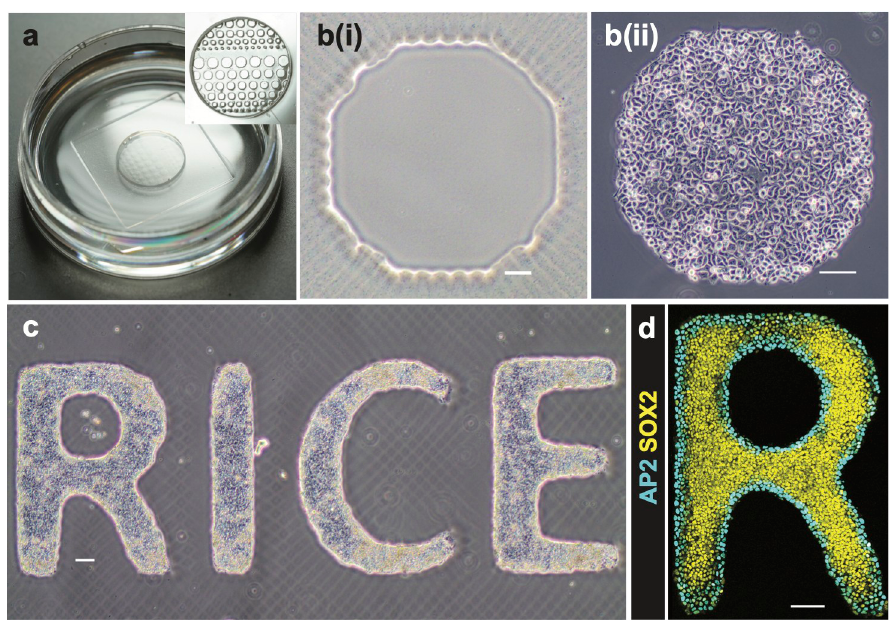
Fig 2. hESC culture and induction on micropatterned PEGDA glass-bottomed dish. ( a ) Photographs of a micropatterned glass-bottomed dish with PBS. ( b ) hESCs attached to micropatterned PEGDA coated glass surface: (i) bright field image of an octagon pattern (ii) hESCs attached well 45 min post cell seeding. Scale bar = 100 μ m. ( c ) hESCs attached to “RICE” pattern were cultured for 3 days. Scale bar = 100 μ m. ( d ) Immunostained hESC patterns for SOX2 and AP2 26 h post BMP treatment at 50 ng/mL. Scale bar = 100 μ m. hESCs self-organized to form an outer ring of extra-embryonic cells (ISL1+), and the inner pluripotent cells (SOX2+).